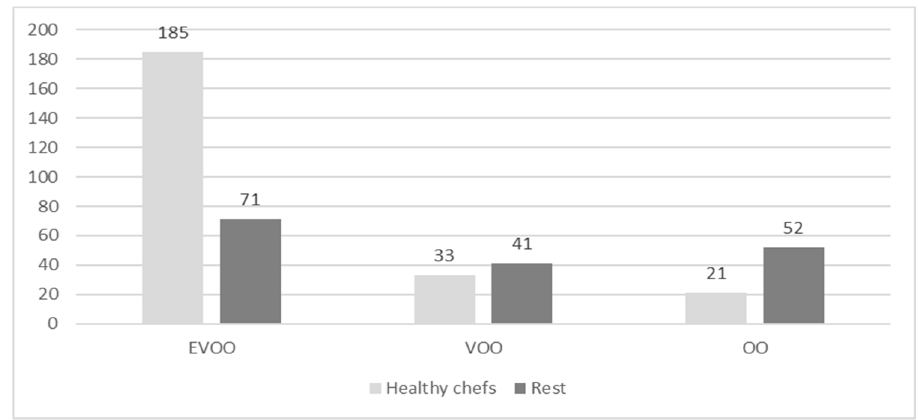
Figure 1. Average monthly consumption of olive oils in kitchen and dining room (litres). Extra virgin olive oil (EVOO), virgin olive oil (VOO), and olive oil